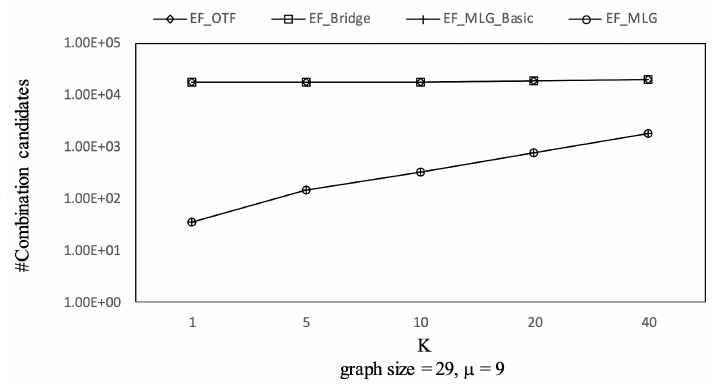
Figure 16. Combination pruning on Ncfu vs. k with graphsize = 29 and µ = 9.